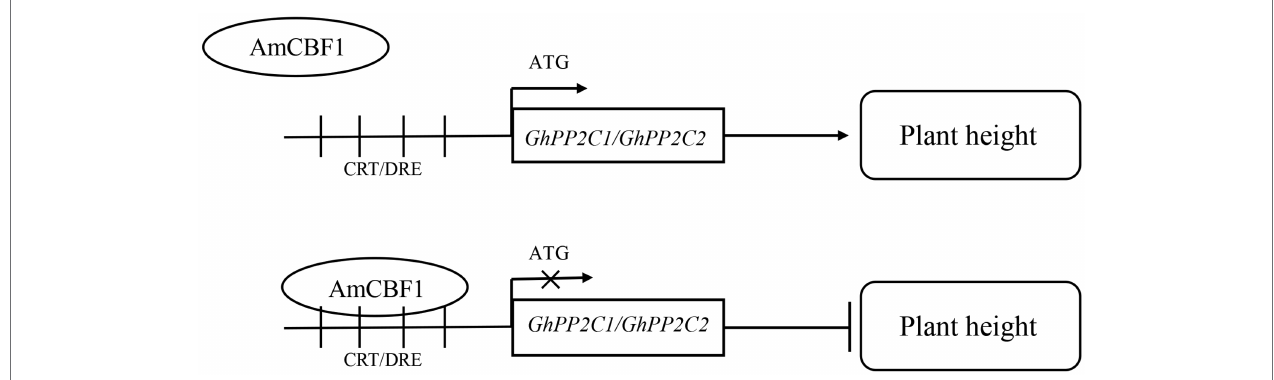
FIGURE 6 | Schematic diagram of a working model for AmCBF1 regulation of GhPP2C genes. The transcription factor AmCBF1 inhibits expression of GhPP2C genes and negatively regulates the growth of upland cotton seedlings by binding to CRT/DRE elements. Bar,